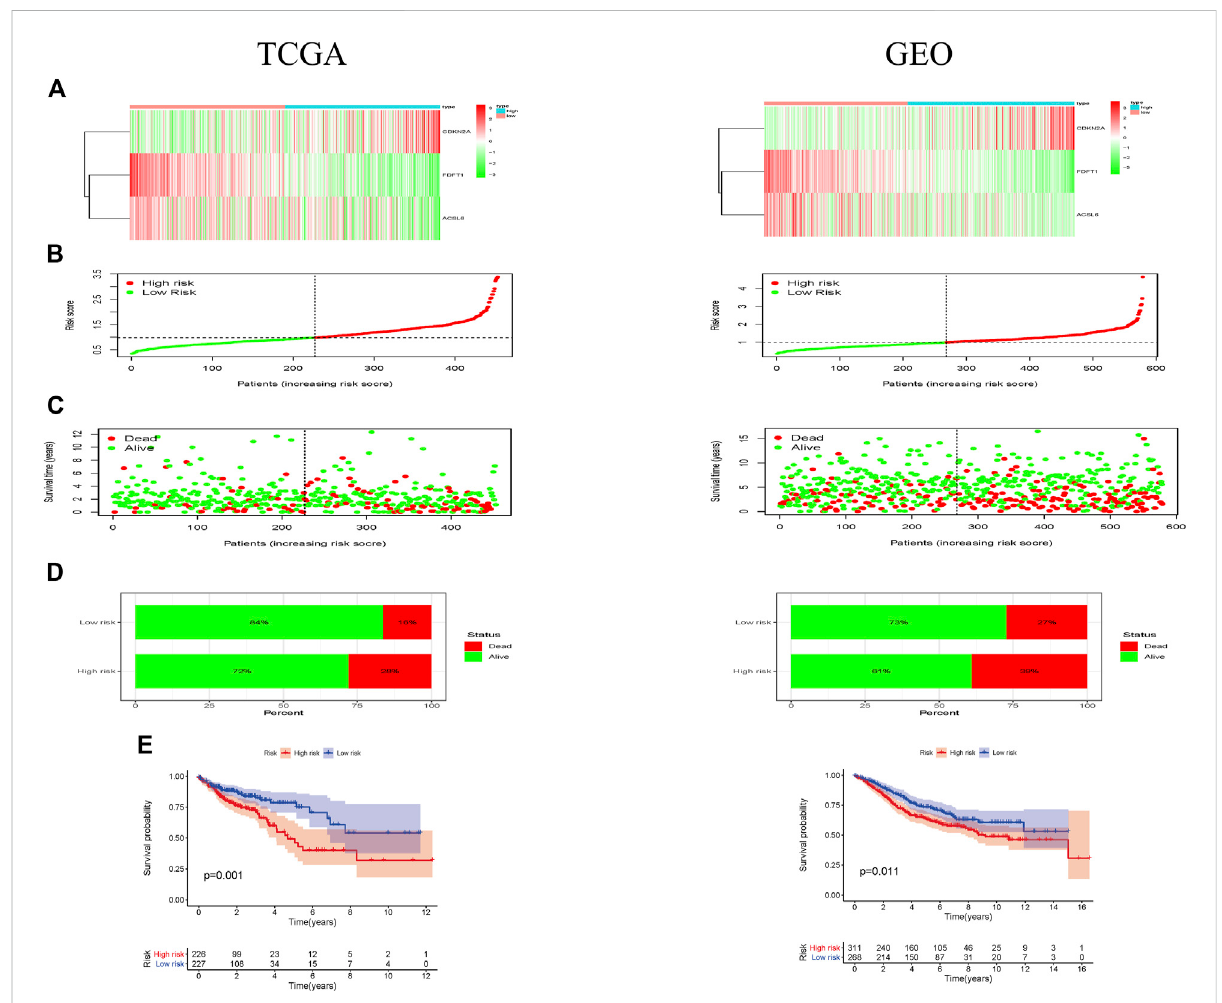
FIGURE 2 Prognostic effect of the ferroptosis-associated gene signature in CRC patients. (A) Heatmaps showed the expressional levels of 3 ferroptosis- associated genes respectively in low-and high-risk groups of TCGA and GEO cohorts; (B) the patients were grouped according to the ferroptosis- associated risk score. (C) The scatter plot demonstrated a difference in the survival status of CRC patients between low- and high-risk groups. The dotindicatesthesurvivalstatusofCRCpatient,whichrankedaccordingtoriskscoreinascendingorder. (D) Mortalityratesofthelow-andhigh- risk groups; (E) Kaplan-Meier curves revealed a survival difference between two risk groups in TCGA and GEO